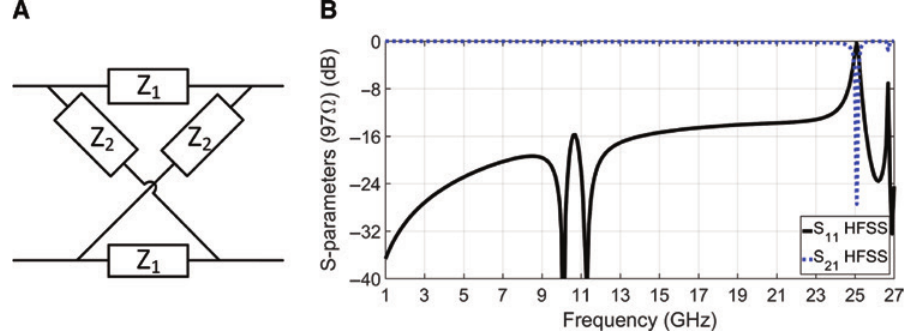
Figure 4: Lattice unit cell circuit model. (A) Lattice circuit topology representing wire/loop unit cell. Obtained from Ref. [66]. (B) Ultra-broadband matched response of a wire/loop unit cell obtained from fullwave simulations. Obtained from